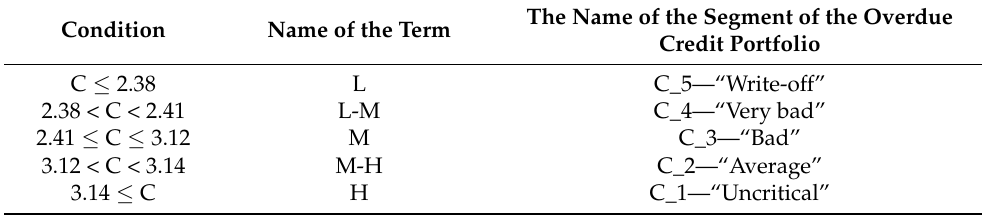
Table 5. The ratio of results obtained and segments of the bank’s overdue credit portfolio.